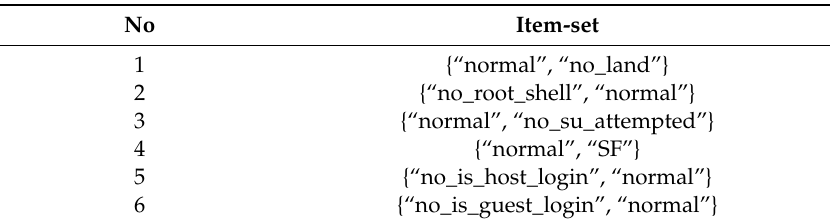
Table 8. Some of the calculated frequent item sets.